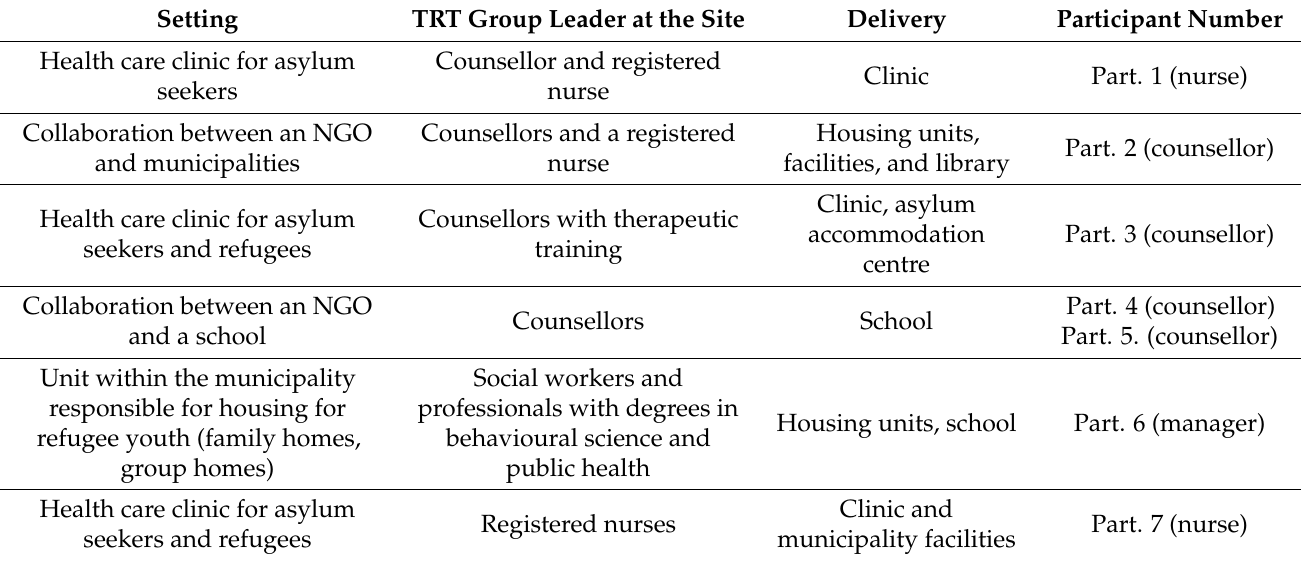
Table 2. The sites included in the